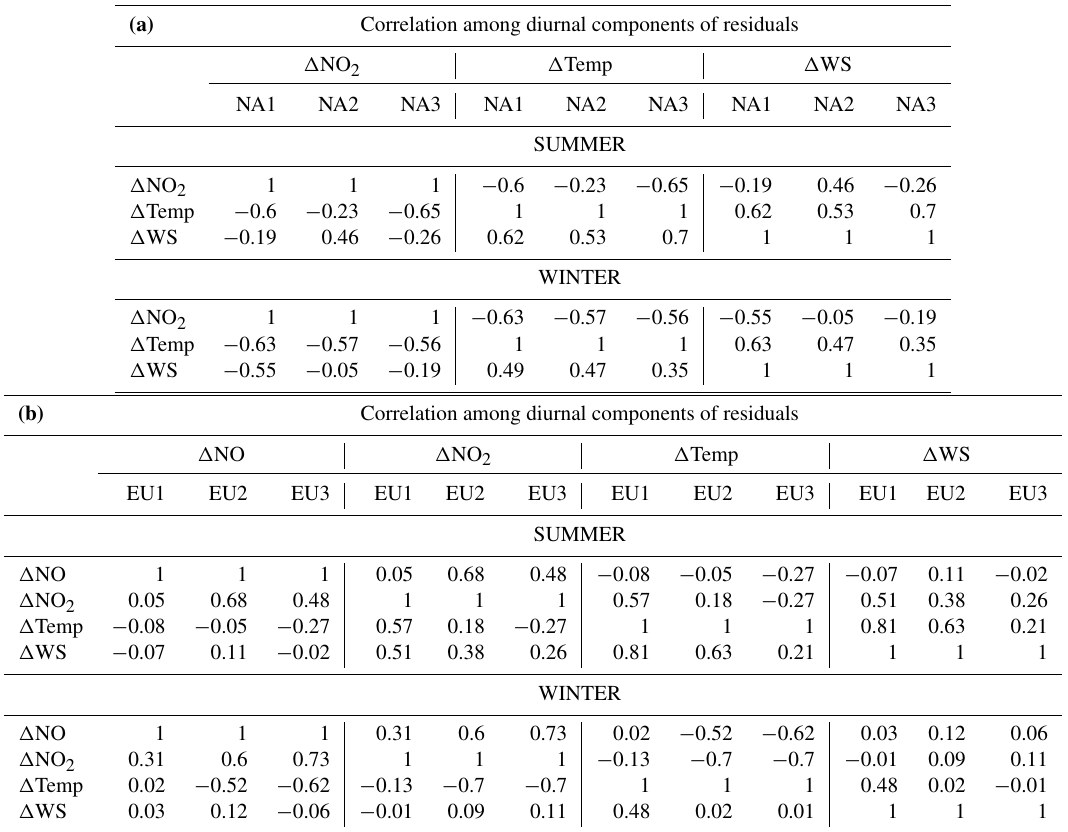
Table 2. Linear correlation coefficient between the diurnal residuals of the regressors of Eq. (3). The residuals are calculated by removing fluctuations faster the ∼ 1.5 days from the measured and modelled time series. All the correlation values are significant up to 1% significance threshold. (a) NA; (b) EU. For each set of variables, the regression analysis includes the rural stations within a maximum differential altitude of